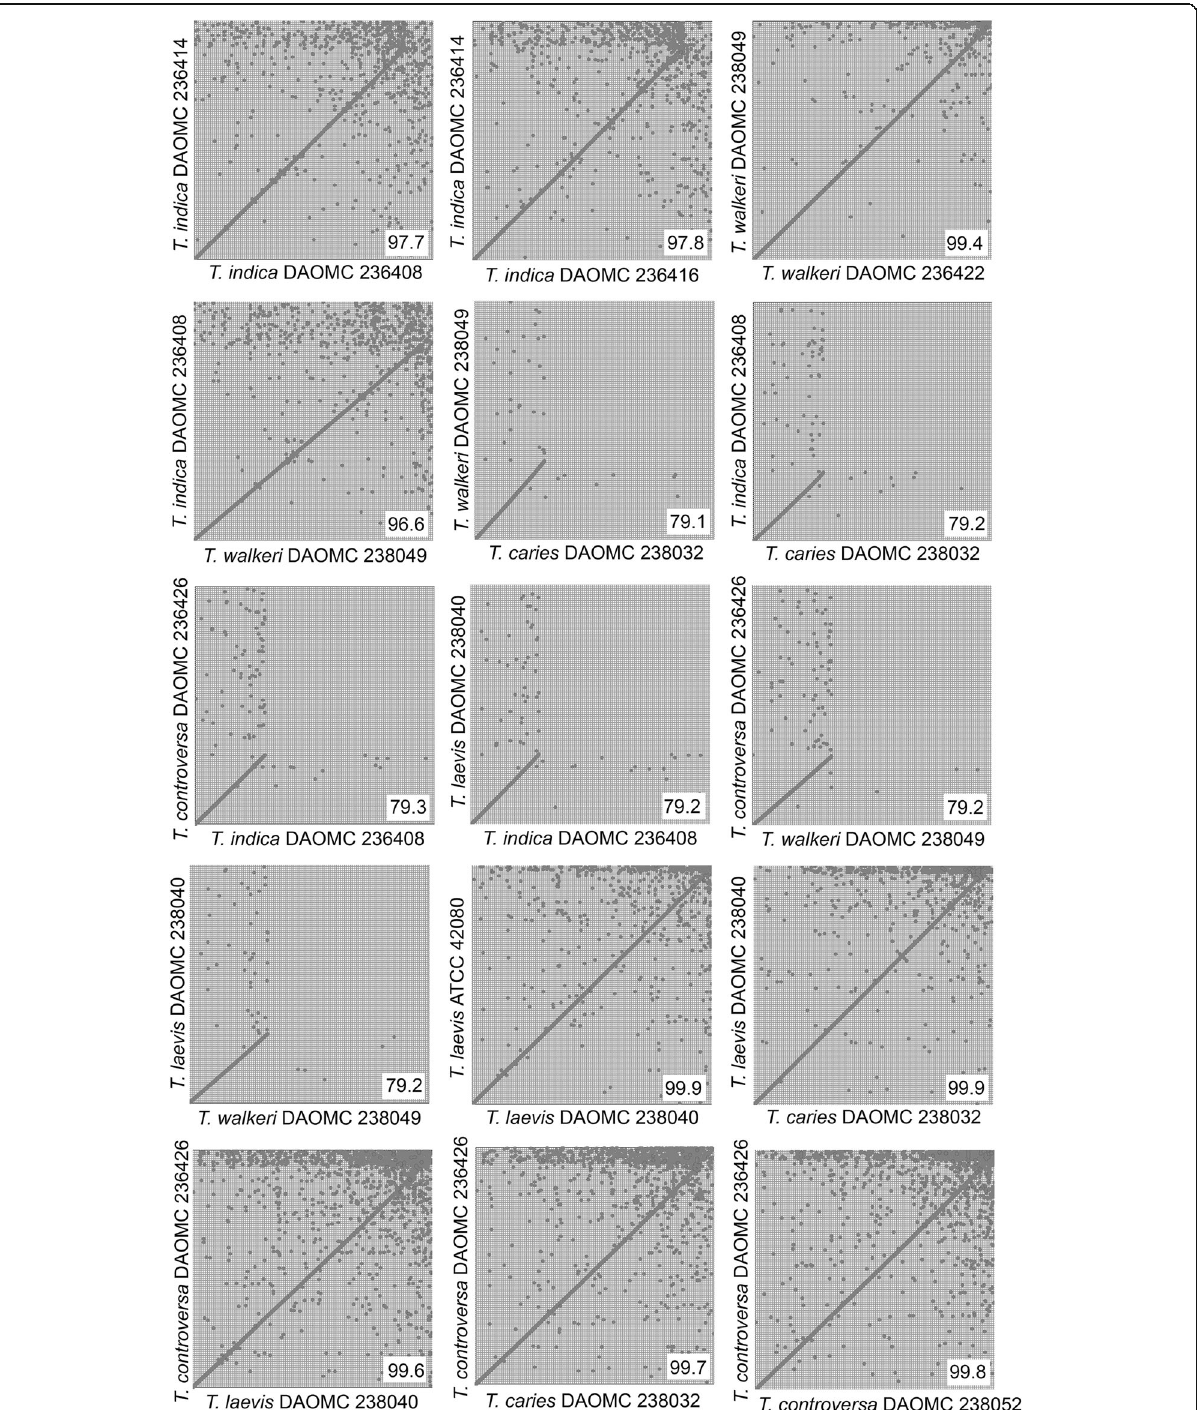
Fig. 1 Mummerplots. Genes predicted from each genome were compared by alignment and the Average Nucleotide Identity (ANI) is shown in the bottom right corner of each